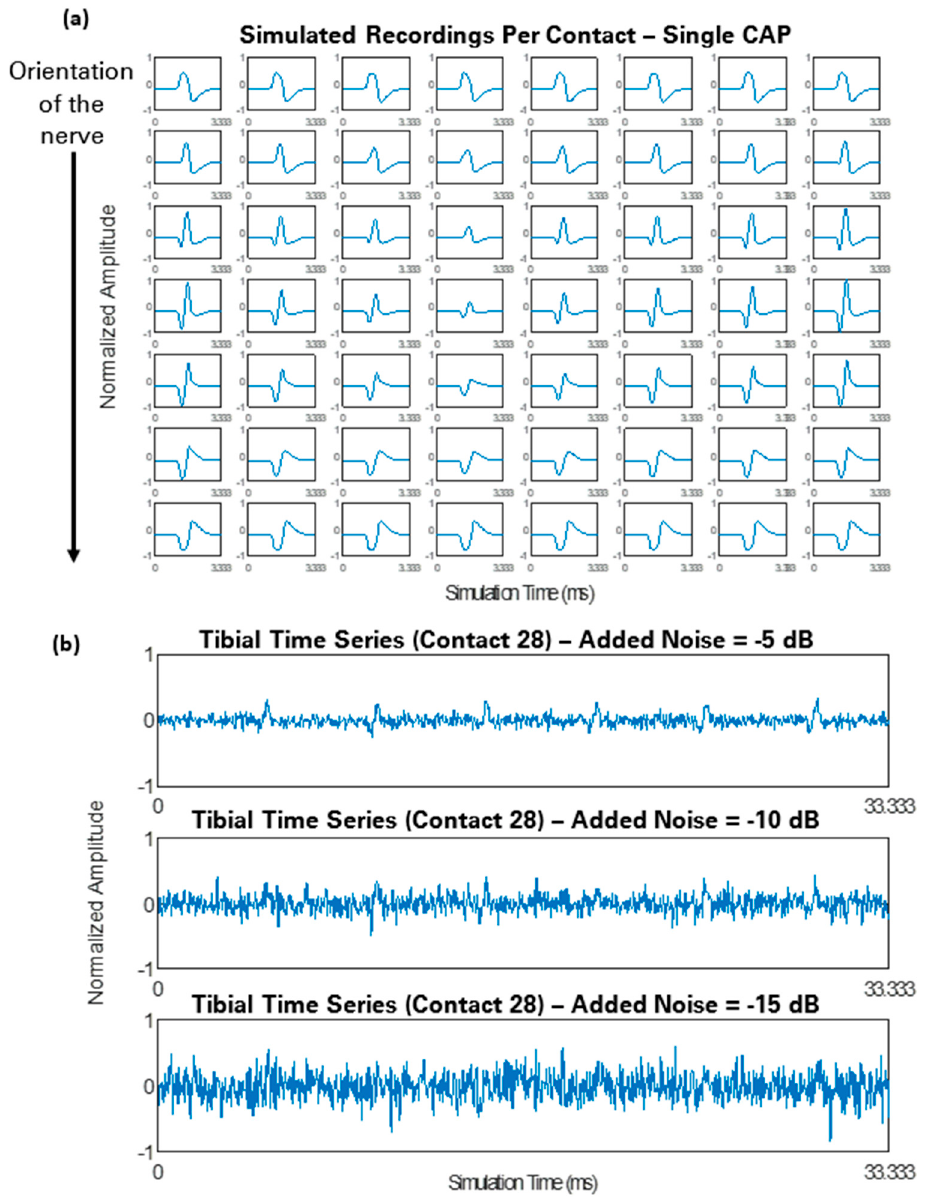
Figure 7. ( a ) Simulated recordings at all 56 contacts of the cuff electrode for a single compound action potential (CAP) propagated through the tibial pathway. ( b ) Segments of the tibial time series measurements of the middle contact (contact 28) at different noise levels (SNR = − 5, − 10, and − 15 dB). All data here have been normalized for visualization purposes.